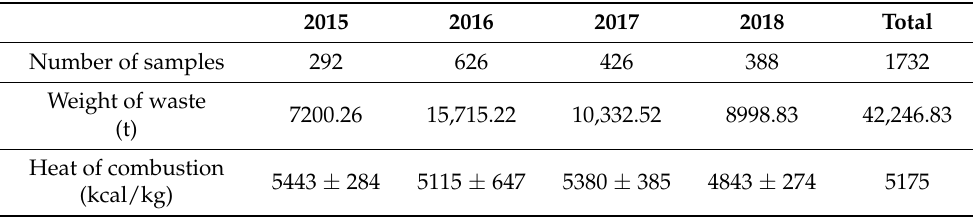
Table 3. Characterization of the residues extracted from the